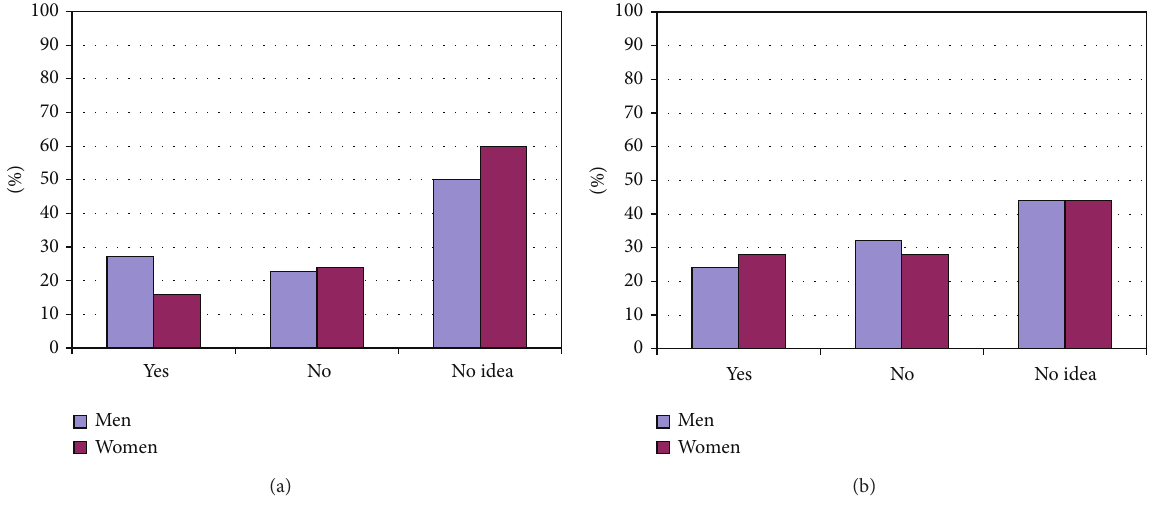
Figure 11: Changes to privacy settings on Twitter. DN (a) and DI (b).